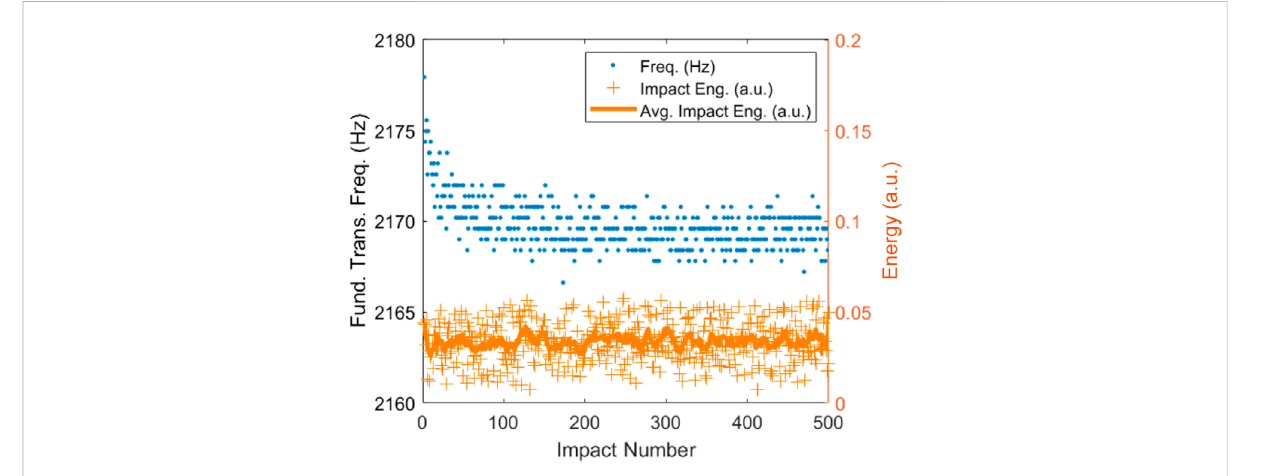
FIGURE 7 Peak fundamental transverse resonance frequency of prismatic neat cement paste sample over sequential impacts and extracted average change of energy from the dynamic electromagnetic impactor.